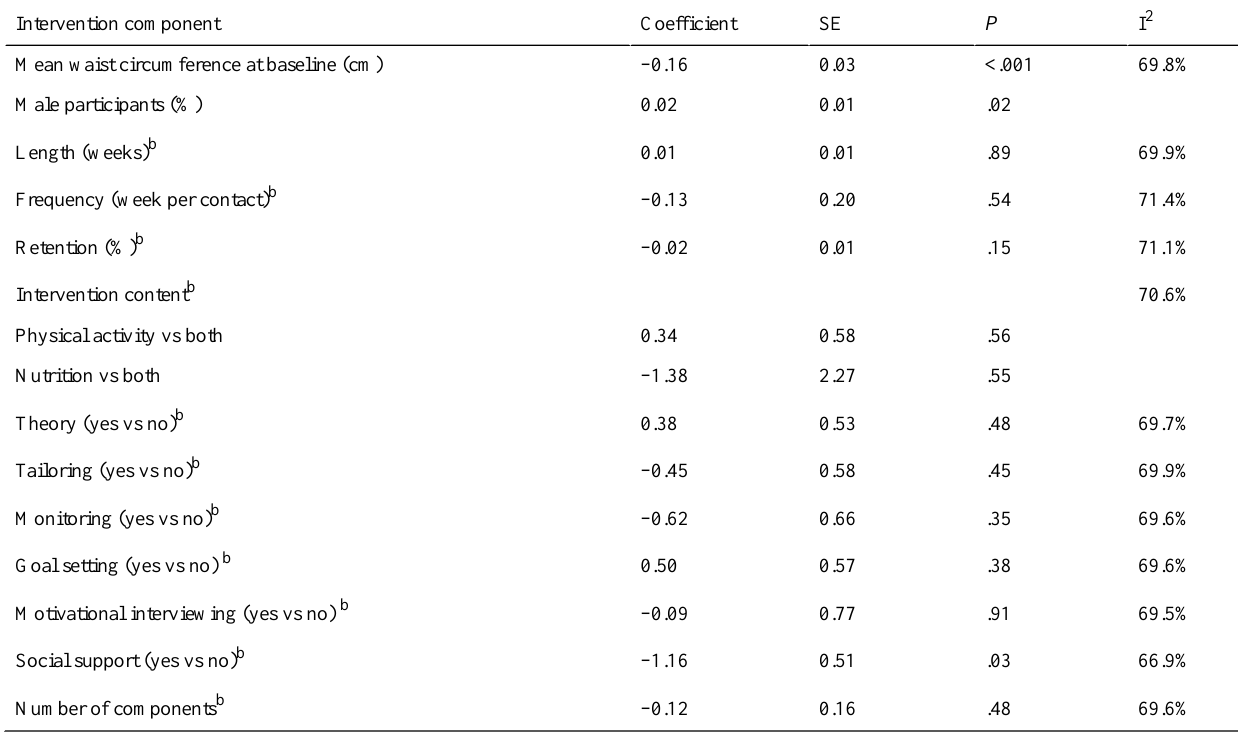
Table 2. Meta-regression of waist circumference change from baseline to posttest. a